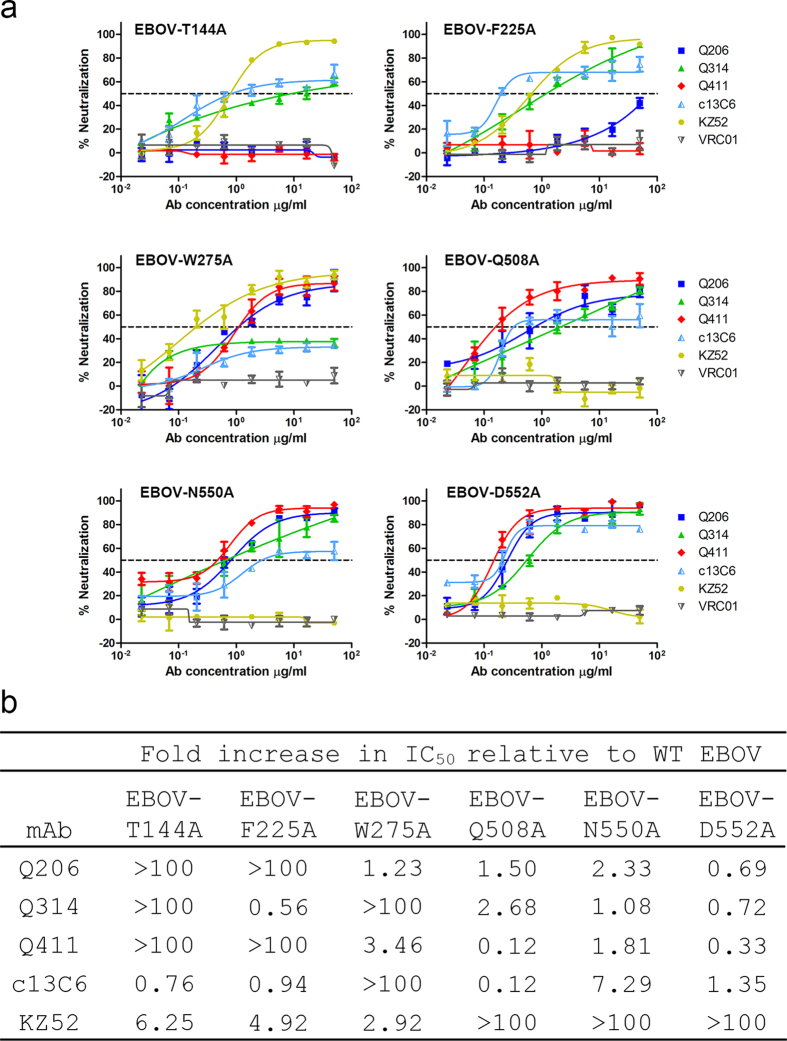
Critical residues on the EBOV envelope glycoprotein in conferring resistance to Q206, Q314 and Q411 neutralization.Comparison of neutralization sensitivity of mutant and wild-type pseudoviruses to Q206, Q314, and Q411 in graphic (a) and numerical (b) format. Dashed line indicates 50% inhibition. Controls antibodies used here include VRC01, a human neutralizing mAb against HIV-1, c13C6 and KZ52, previously isolated neutralizing mAbs against EBOV. Data presented are average values from at least two independent experiments and the error bars indicate for the standard error of the mean (SEM).